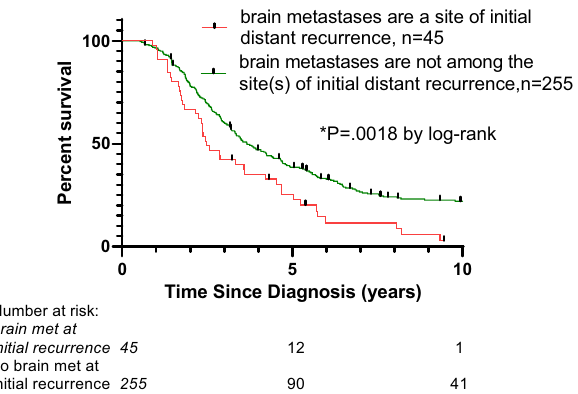
Fig. 4 Overall Survival with distant recurrence. Overall survival from the time of diagnosis for patients with recurrent breast cancer strati fi ed by the presence or absence of brain metastases among the initial sites of disease recurrence.